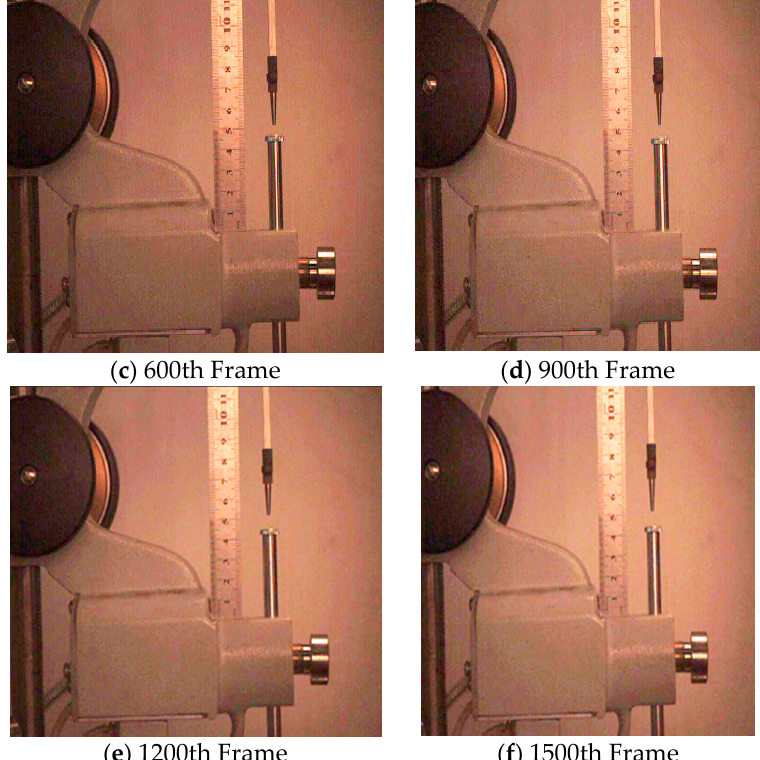
Figure 3. Converting video to JPG images: ( a ) Initial state; ( b ) 300th frame; ( c ) 600th frame; ( d ) 900th frame; ( e ) 1200th frame; ( f ) 1500th frame.